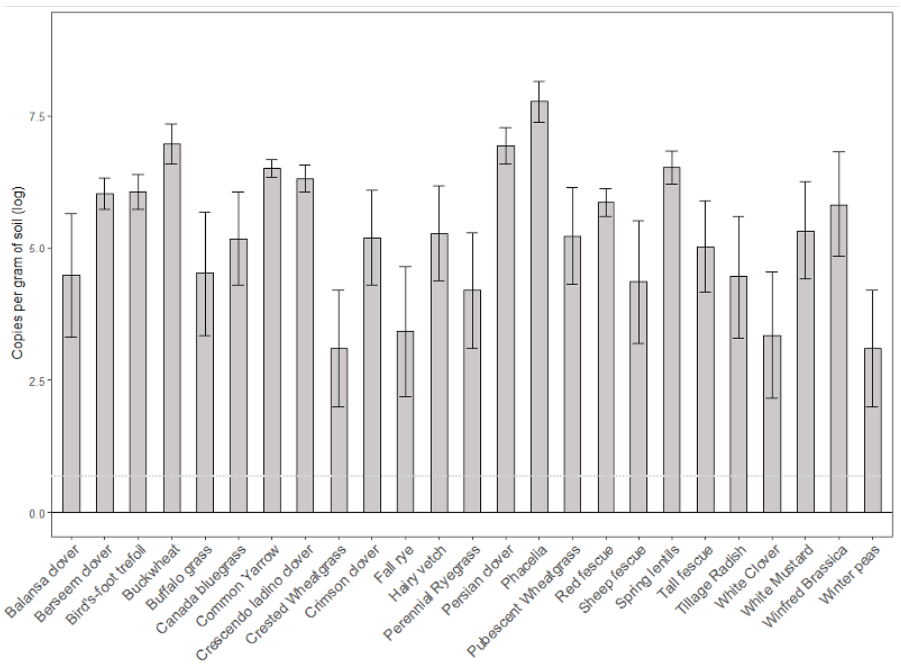
Figure 2. Log concentration of Ilyonectria DNA (copy number per gram of soil) isolated from soil conditioned by each cover crop after a three-month growth period. Data is shown in the log transformation. Dotted line represents the amount of inoculum added to each pot, for comparison.